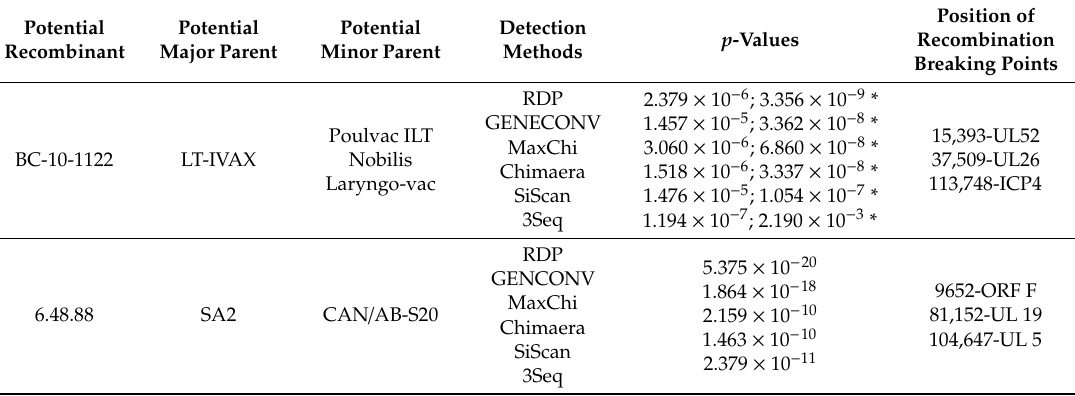
Table 4. Recombination signals involving Canadian ILTV isolates, recombination analysis carried out on Recombination Detection Program (RDP4) software.